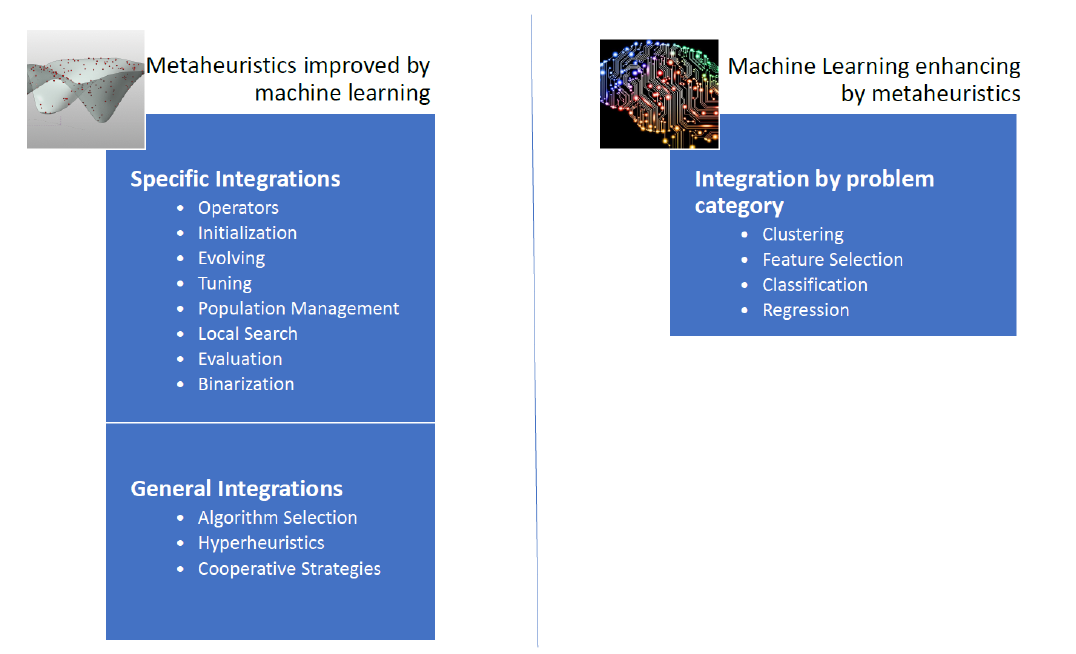
Figure 1. General scheme: Combining Machine Learning and